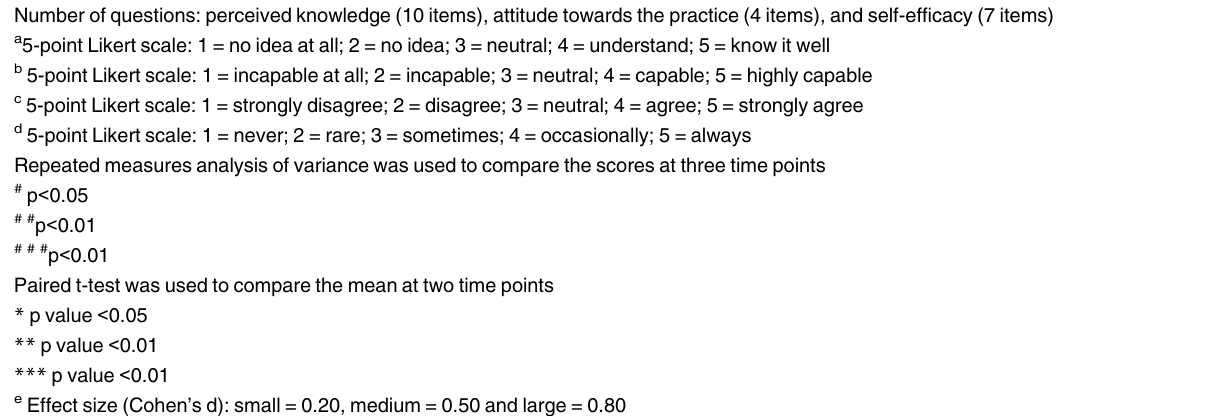
Pre- Immediately after training